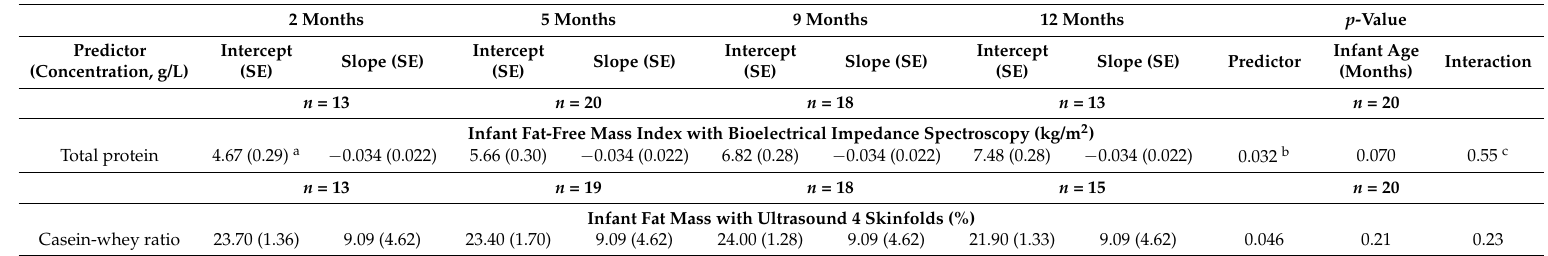
Table A2. Associations between concentrations of human milk proteins and infant characteristics.